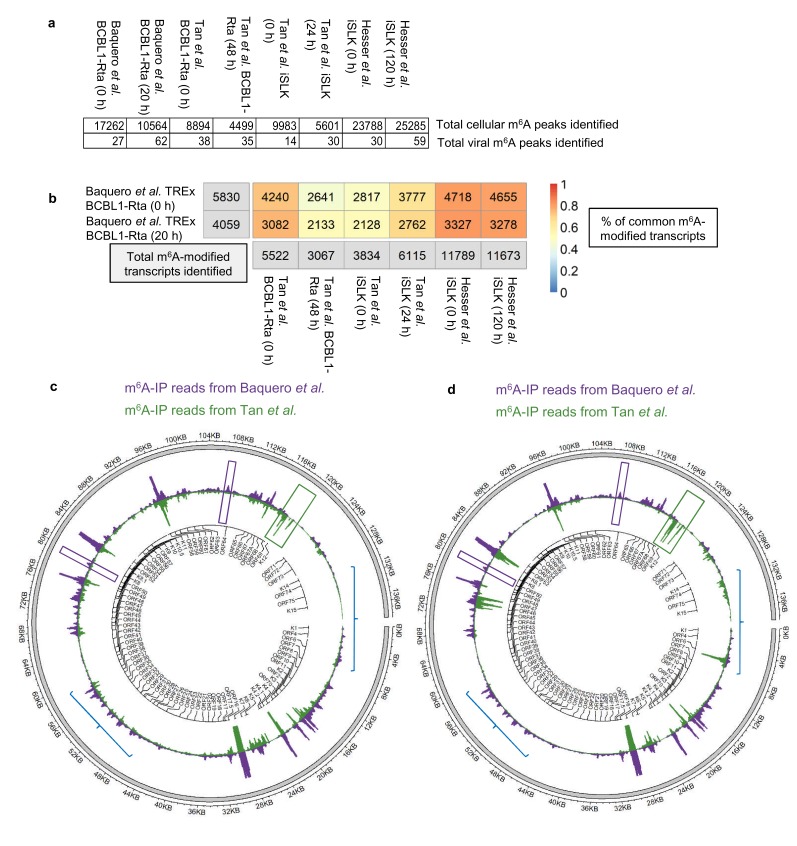
Comparison of epitranscriptomic maps in different KSHV-infected cell lines (a, b) Fastq files were downloaded from SRA (GEO accessions: GSE93676 and GSE104621) using sratoolkit.Raw sequencing data were subjected to quality control and processing as described in methods. Reads were aligned to a combined human hg38 and KSHV genome reference. m6A peaks were identified with m6aViewer version 1.6.1. Peaks were filtered to keep only those with a minimum of 20 mean reads, 1% FDR (benjamini-hochberg) and an enrichment of 4-fold m6A-IP/input. Overlapping m6A peaks between replicates were collapsed using GenomicRanges R package and only peaks detected across all replicates were kept for further comparisons. (b) Total number of overlapping m6A-modified transcripts identified between replicates are displayed for each dataset and time point in the grey boxes. The percentage of the total m6A-modified transcripts identified in our dataset that overlap with previously published studies in TREx BCBL1-Rta and iSLK cells (Hesser et al., 2018; Tan et al., 2018) is shown, with 1 being 100%. (c) Comparison of the lytic epitranscriptomic map from our study and the one performed by Tan et al., both carried out in TREx BCBL1-Rta. Circos plot of m6A-IP read coverage across the viral episome is shown for both studies. Coverage tracks were scaled to account for differences in library sizes. KSHV gene positions are indicated by the central track. Some differences in the identified m6A peaks between the two datasets are highlighted. (d) As described in c, but comparing Baquero et al. lytic TREx BCBL1-Rta cells with lytic iSLK cells from Tan et al.